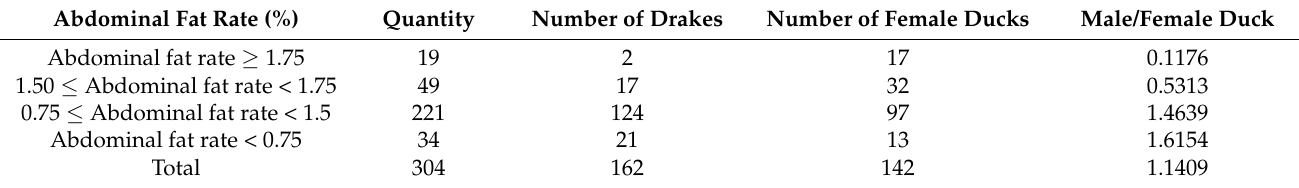
Table 2. Distribution of abdominal fat percentage in F2 generation